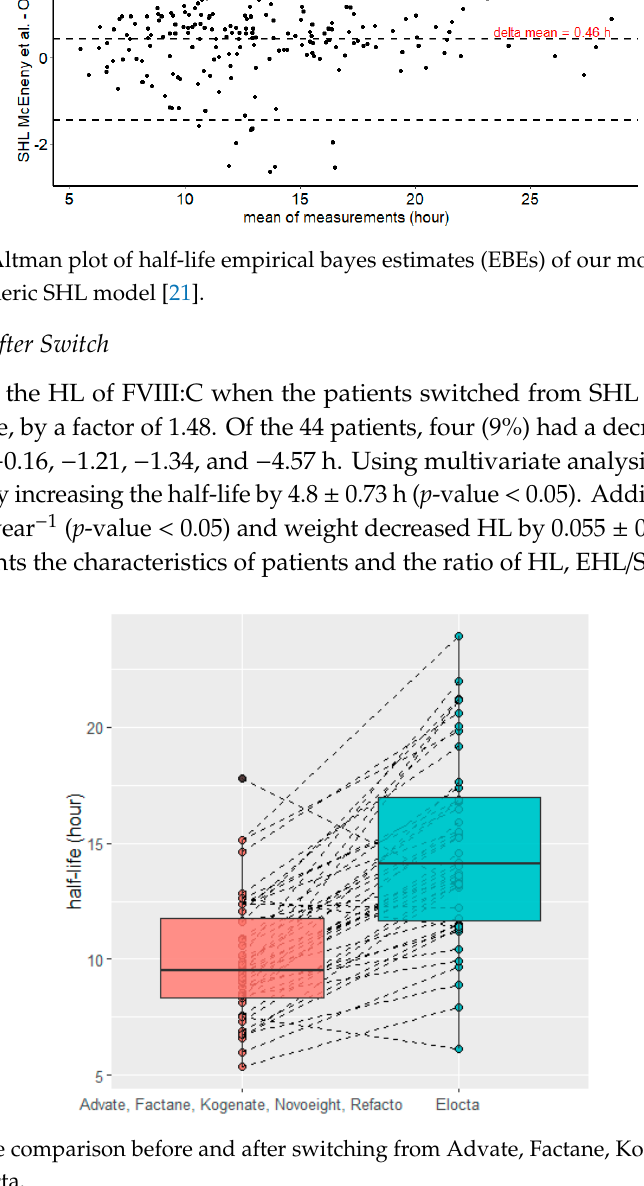
Figure 4. Comparison between estimated half-life from our model and McEneny-King’s et al.’s generic standard half-life (SHL) model [21].